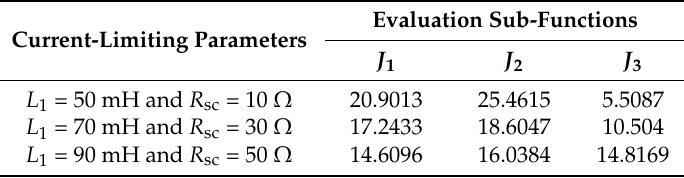
Table 2. Calculation results of the three evaluation sub-functions under different current-limiting parameters (external fault).